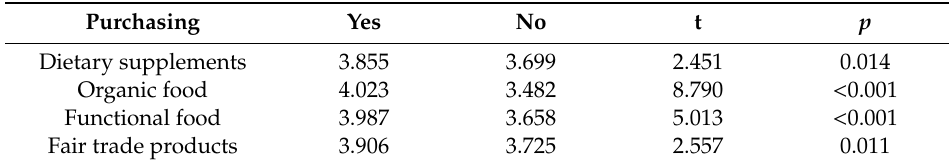
Table 3. The importance attached to salt content information on food packaging by purchasing certain products ( t tests).